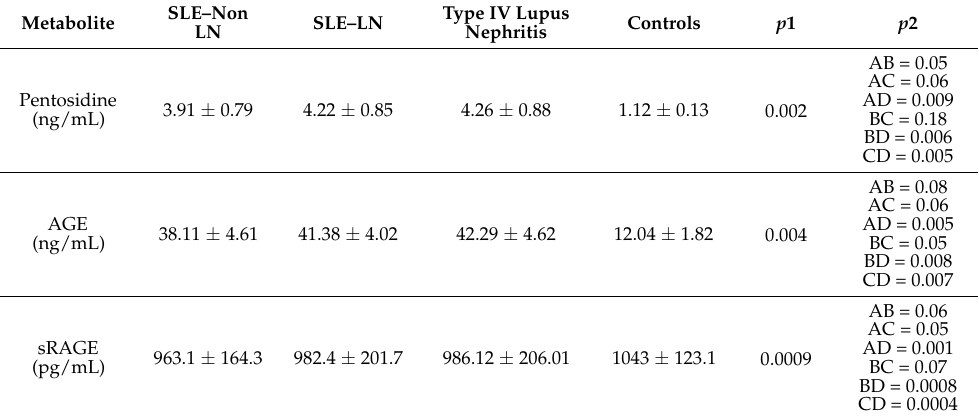
Table 5. Carbohydrate oxidation in studied